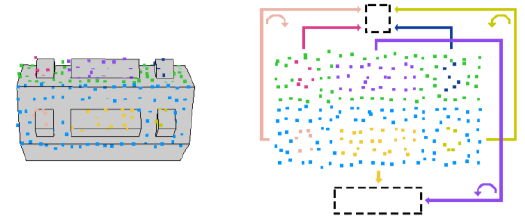
Figure 7. Example of the initial grouping and the initial rough transformation process.